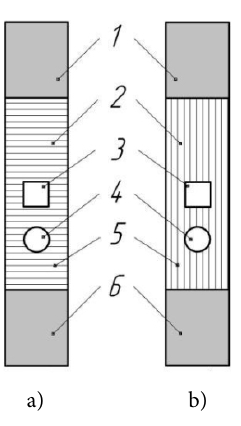
Fig. 2. Sample and scheme Fig. 3. Measuring the complex switching diagram (a), the sample clamping diagram (b) and the sample in clamps (c): 1 – Sample; 2 – AE sensor; 3 – tension sensor; 4 – clamp; 5 – loading system; 6 – dynamometer; 7 and 8 – preamps; 9 – AE device POCKET AE- 2 (U.S.); 10 – AE- 15 unit AF (Moldova); 11 – card data collection; 12 – strain